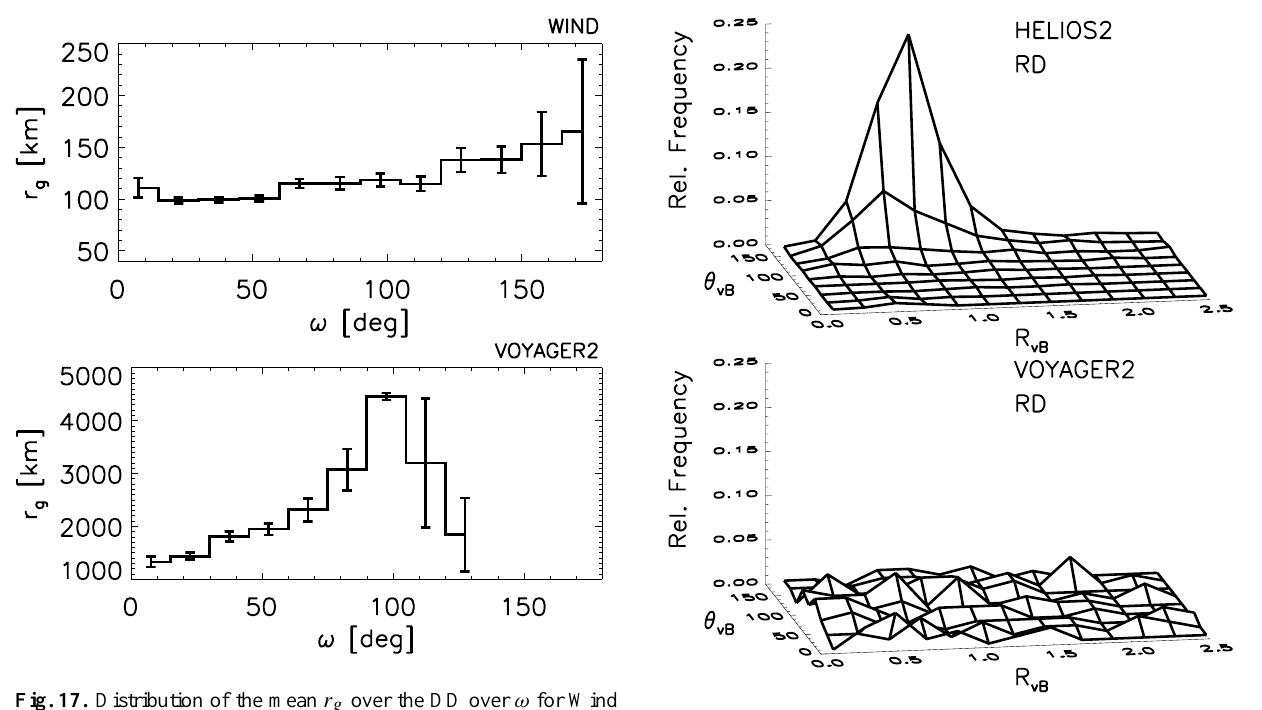
Fig. 18. Distribution of the RDs over θ vB and R vB for Helios 2 (top) and Voyager 2 (bottom) as a 2D